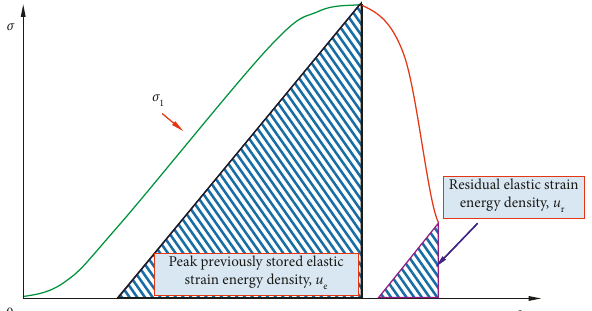
Figure 7: Schematic diagram of calculation of axial elastic energy density of the rock